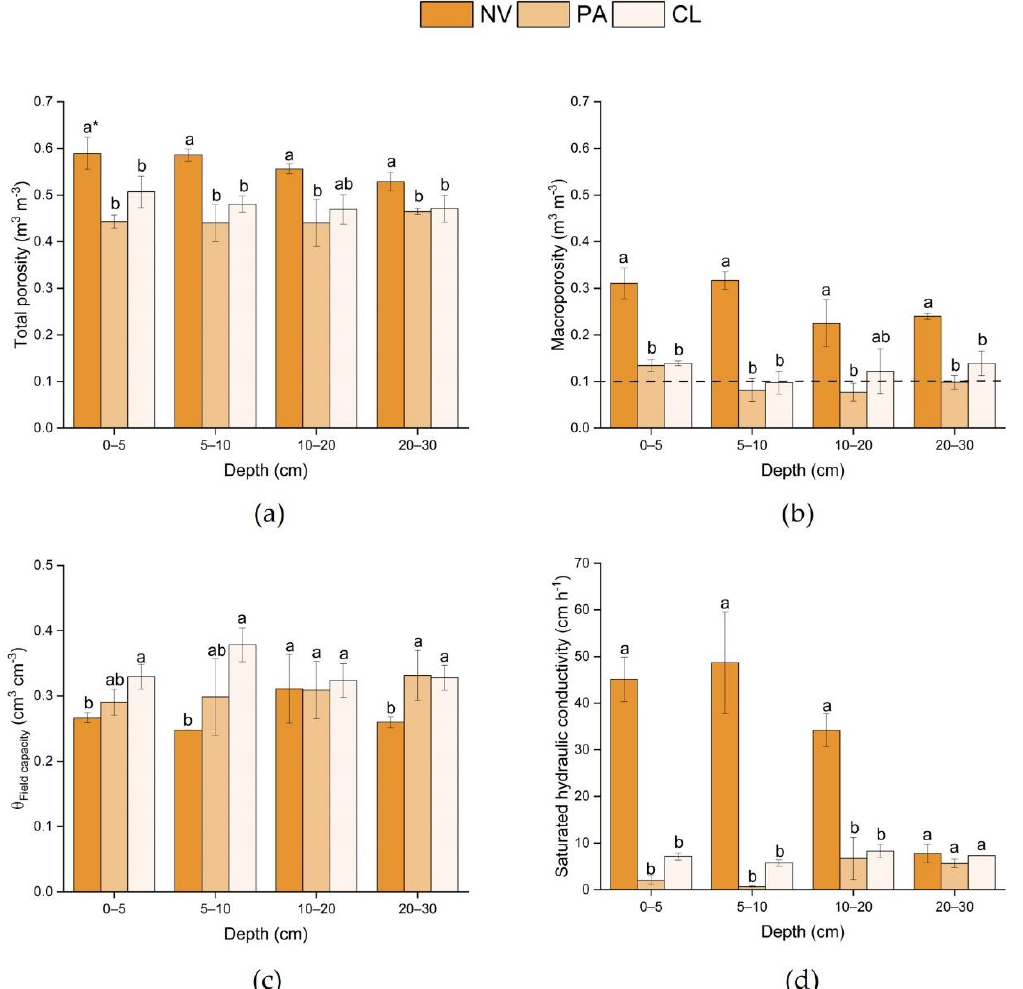
Figure 3. ( a ) Total porosity, ( b ) macroporosity, ( c ) water content at field capacity (C), and ( d ) saturated hydraulic conductivity at 0–5, 5–10, 10–20, and 20–30 cm soil layers under cropland (CL), pasture (PA), and native vegetation (NV) areas. The dashed line indicates possible limiting values for proper root growth for macroporosity [49]. * Means followed by the same letter within the same soil layer are equal to Tukey ’ s test ( p < 0.05). Vertical bars represent the standard deviation of the mean.